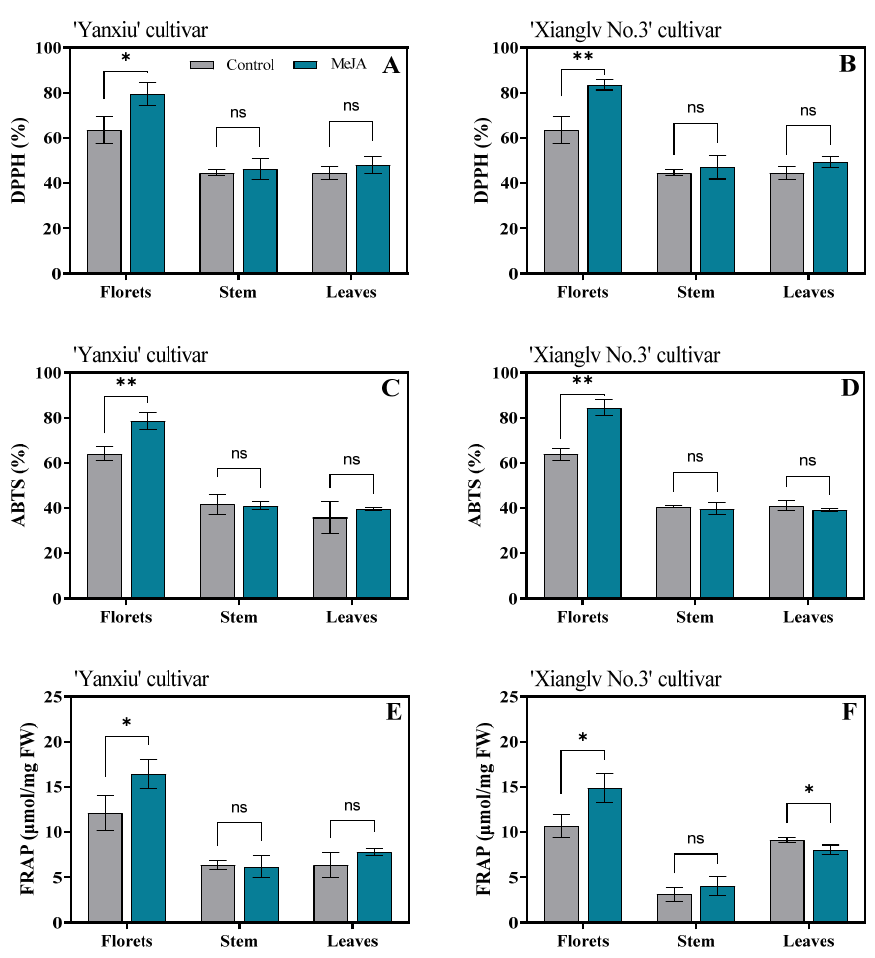
Figure 5. Effects of MeJA on DPPH( A , B ), ABTS ( C , D ), and FRAP ( E , F ) in broccoli florets, stem, and leaves. DPPH: 2,2-di-phenyl-1-picrylhydrazyl radical scavenging capacity; ABTS: trolox-equivalent antioxidant capacity; FRAP: ferric-reducing antioxidant power; FW: fresh weight; Control: the plants were sprayed with distilled water; MeJA: the plants were sprayed with 40 µ mol/L MeJA. The data are displayed with the mean ± SD of three replications. Values with ns, * and ** are significantly different at p > 0.05, p < 0.05, and p < 0.01.